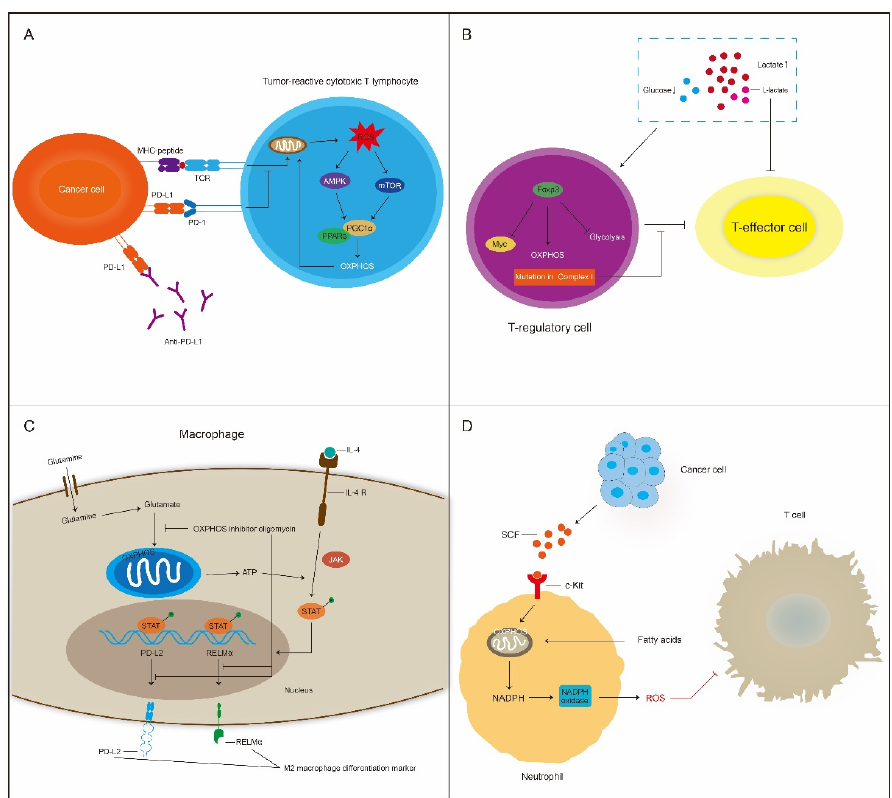
Figure 3. OXPHOS plays a dual role in cancer immunity. ( A ) Anti − PD − L1 agent promotes mitochondrial function in tumor − reactive cytotoxic T lymphocytes (CTLs). ( B ) The Foxp3 − mediated metabolic phenotype of Tregs may result in resistance to anticancer immunotherapy. ( C ) OXPHOS is required for M2 macrophage differentiation. ( D ) Neutrophils may mediate immune suppression in the tumor microenvironment (TME).